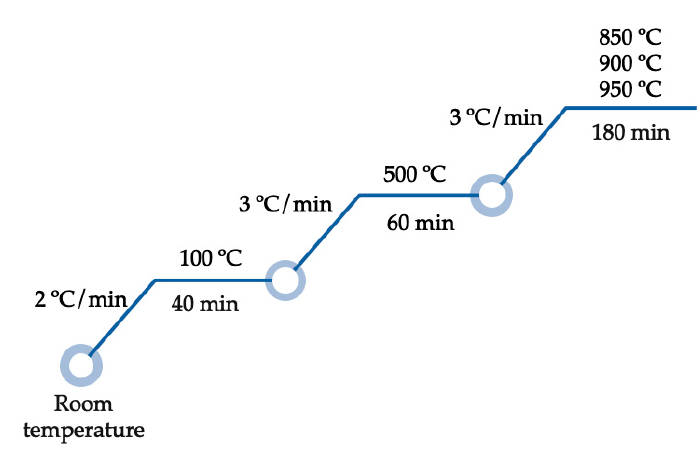
Figure 1. Experimental conditions for the preparation of composites: monoliths (SLMC) and pellets (PLMC).